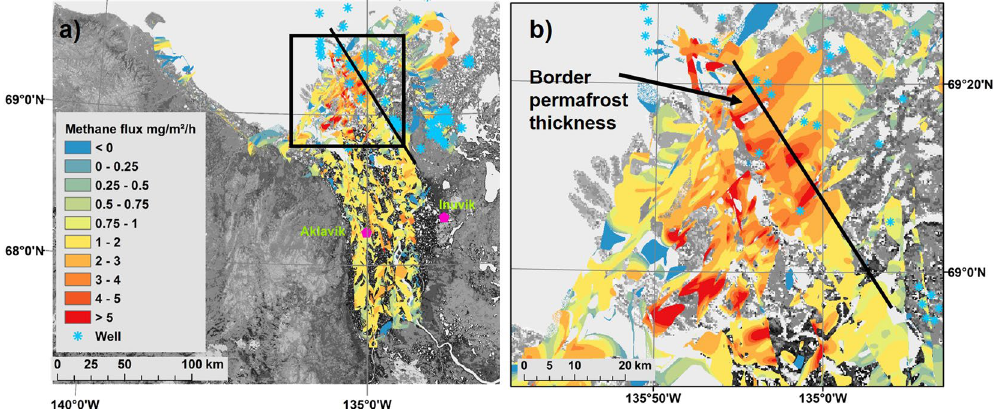
Figure 2. CH 4 flux map with location of wells. ( a ) CH 4 flux topography for both years containing data with a standard error < 30%. Fluxes > 5.0 mg m − 2 h − 1 are considered to be of geologic origin. Blue asterisks show the location of wells (oil or gas wells) derived from literature data. The locations of the towns of Inuvik and Aklavik are shown for orientation. ( b ) Magnification of the area with the highest CH 4 fluxes marked with the black square in Fig. 2a. Legend as in Fig. 2a. West of the black line the permafrost is discontinuous and thin, east of it continuous and thick. Data for background map from ref. 46. The map in Fig. 2 was created using